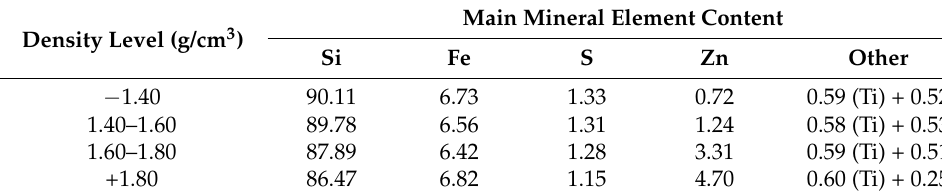
Table 3. Main element content of mineral-enrichment area in − 0.045 mm tailings.